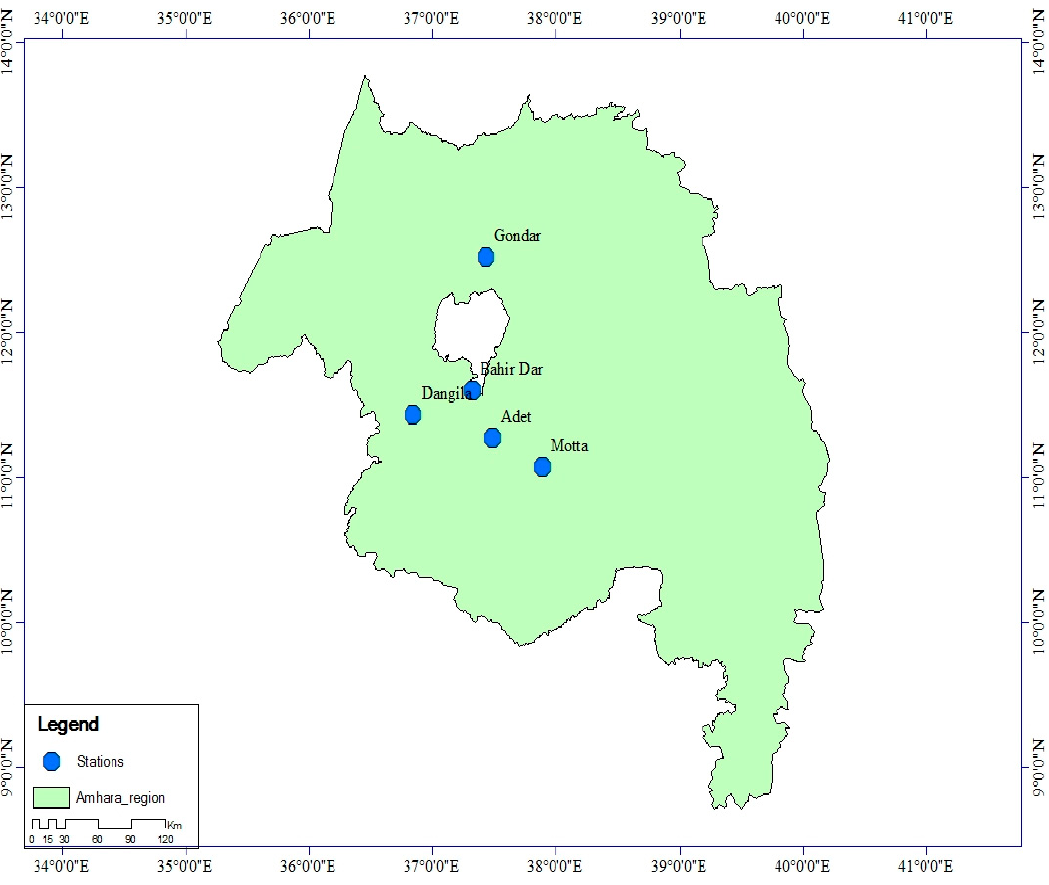
Figure 1. Map of the study region.